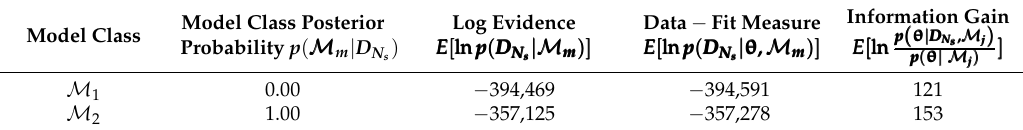
Table 7. Comparison of Bayesian updating results for model class M 1 and M 2